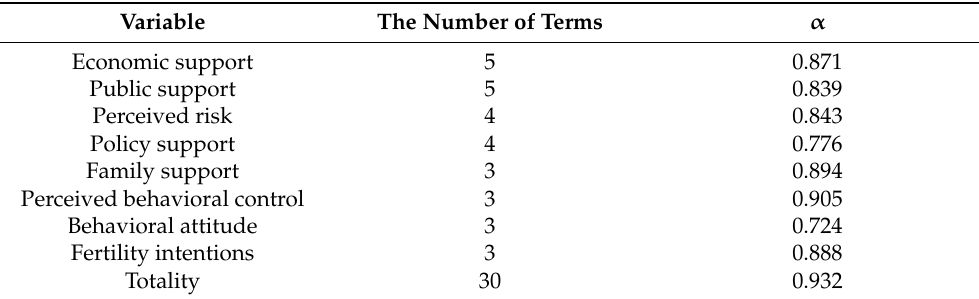
Table 5. Results of the reliability